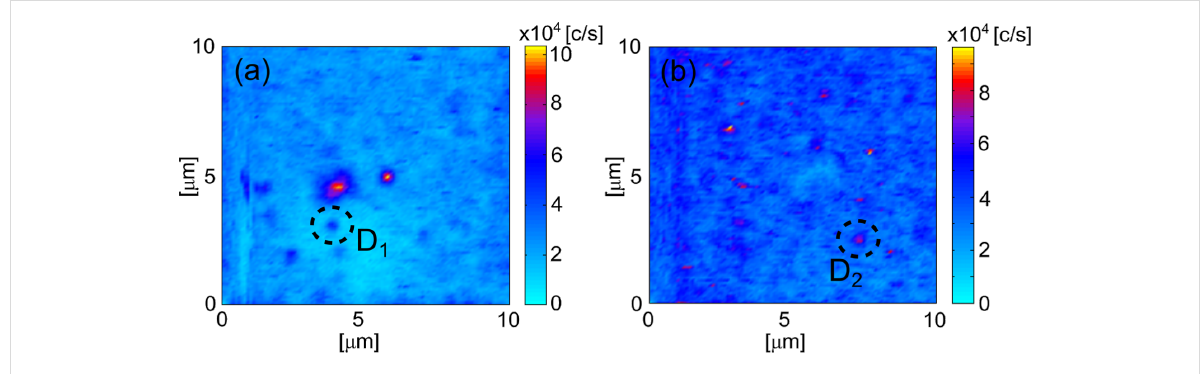
Figure 3: 10 × 10 μ m 2 confocal scans of two single-photon emitters (a) defect D 1 and (b) defect D 2 found on the a-450 °C-TiO 2 sample. The colour bars represent the count rate at the detector.